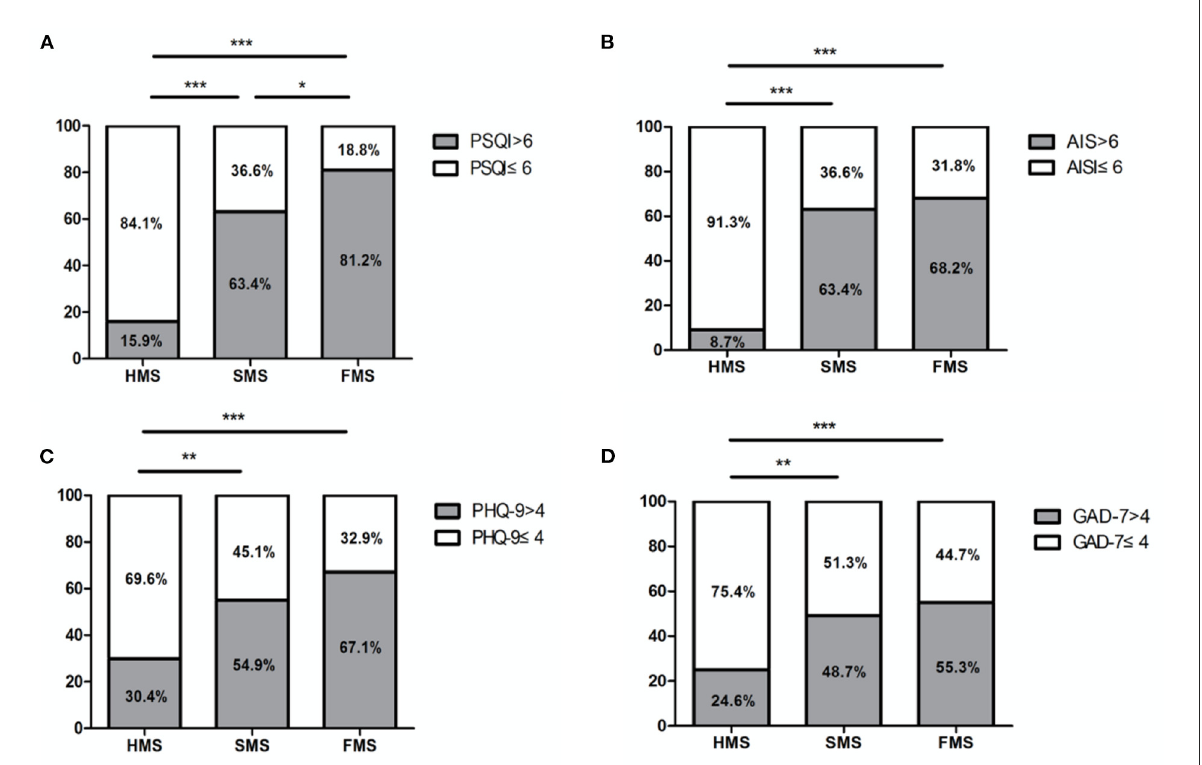
FIGURE1 Proportion of poor sleep quality, insomnia, depressive symptoms, and anxiety symptoms among HMS, SMS and FMS. (A) The FMS and SMS had significantly higher proportion of poor sleep quality than HMS, the FMS had significantly higher proportion of poor sleep quality than SMS. (B) The FMS and SMS had significantly higher proportion of insomnia than HMS. (C) The FMS and SMS had significantly higher proportion of depressive symptoms than HMS. (D) The FMS and SMS had significantly higher proportion of anxiety symptoms than HMS. FMS, first-line medical staff; SMS, second-line medical staff; HMS, at home medical staff; PSQI, Pittsburgh Sleep Quality Index; AIS, Athens Insomnia Scale; PHQ-9, Patient Health Questionnaire depression module-9; GAD-7, Generalized Anxiety Disorder-7; * p < 0.05, ** p < 0.01, *** p <